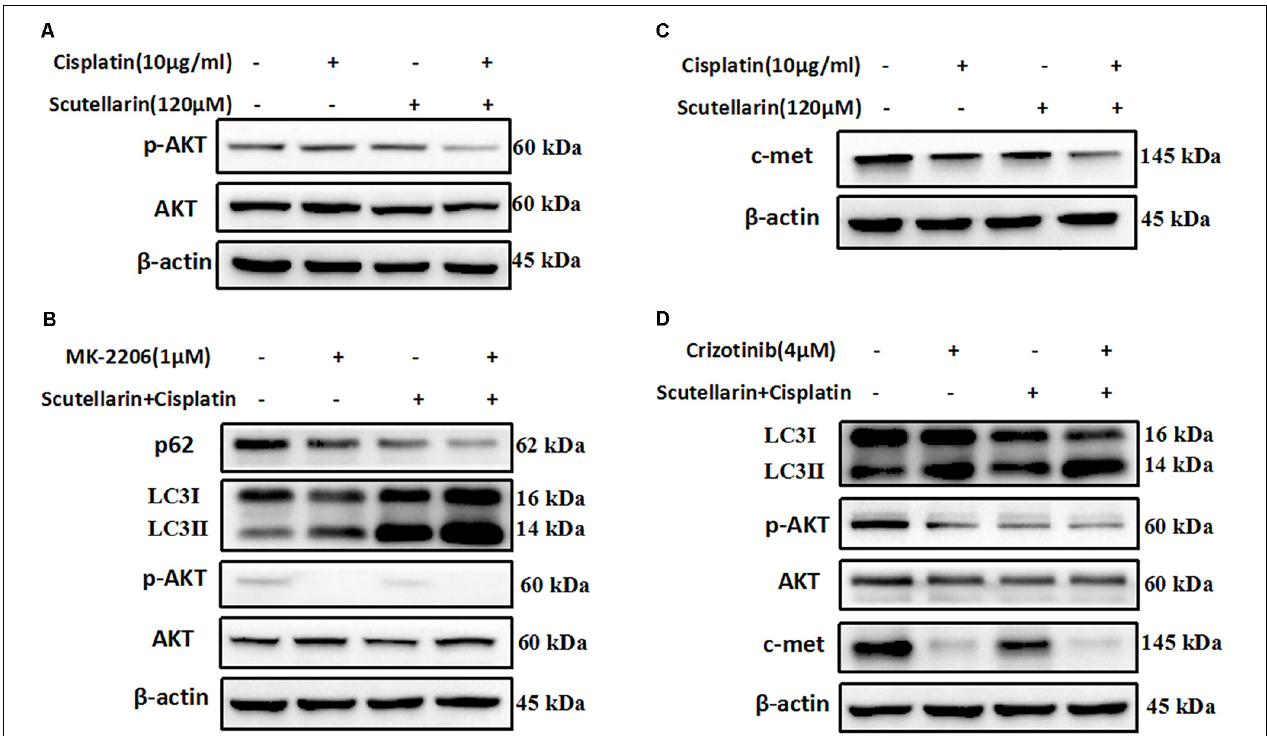
FIGURE 5 | Scutellarin increased cisplatin-induced autophagy through suppressing c-met/AKT signaling pathways. (A) Cells were treated by cisplatin with or without scutellarin, the protein expressions of AKT and p-AKT were determined by western blotting. (B) The expression levels of LC3, AKT, p-AKT were detected by western blotting in A549/DDP cells coincubated with MK-2206. (C) Western blot analysis of the protein of c-met. (D) The effect of crizotinib on the expression of LC3, AKT, p-AKT, c-met was analyzed by western blot